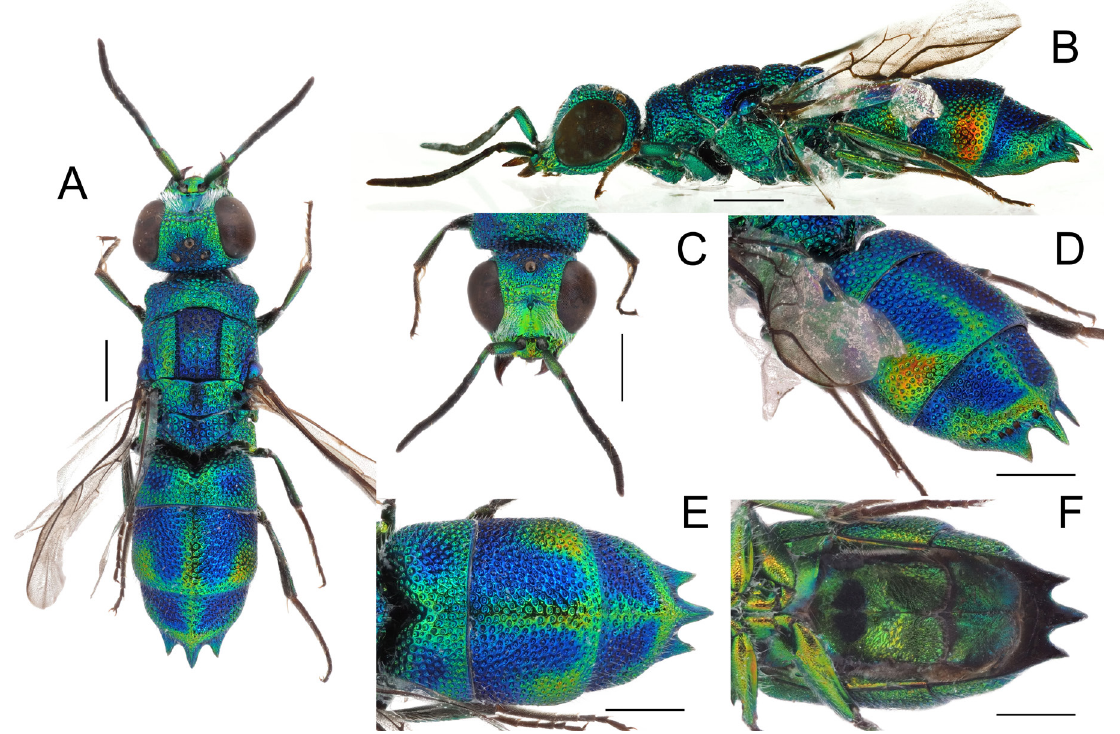
Fig. 5. Trichrysis poseidonia sp. nov., ♀, holotype (NHME). A . Habitus, dorsal view. B . Habitus, lateral view. C . Head, frontal view. D . Metasoma, postero-lateral view. E . Metasoma, dorsal view. F . Metasoma, ventral view. Scale bars: 1.0